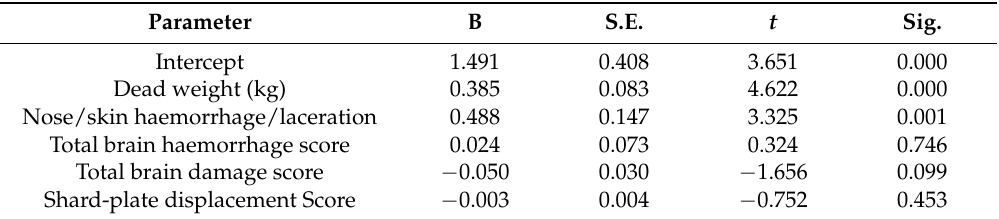
Table 4. Parameter estimates from the GLM testing for an effect of dead weight (kg), brain haemorrhage score, macroscopic brain damage score, and nose/skin haemorrhage/laceration on movement score.